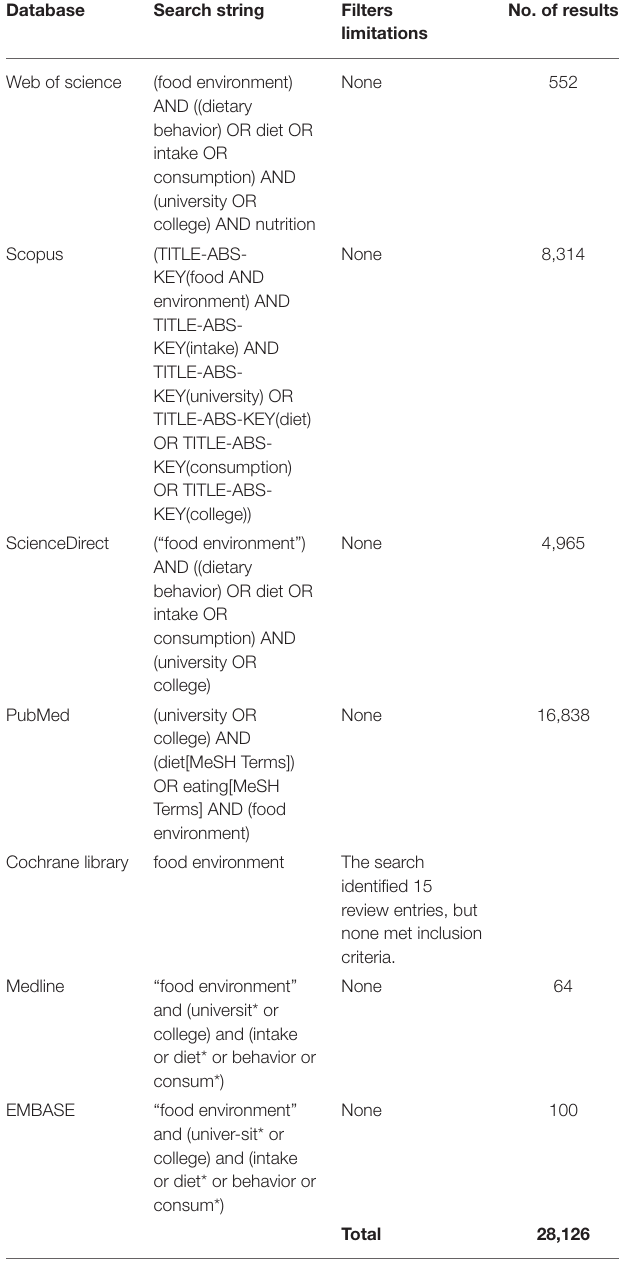
TABLE 2 | Keyword and search strategy used in each database.